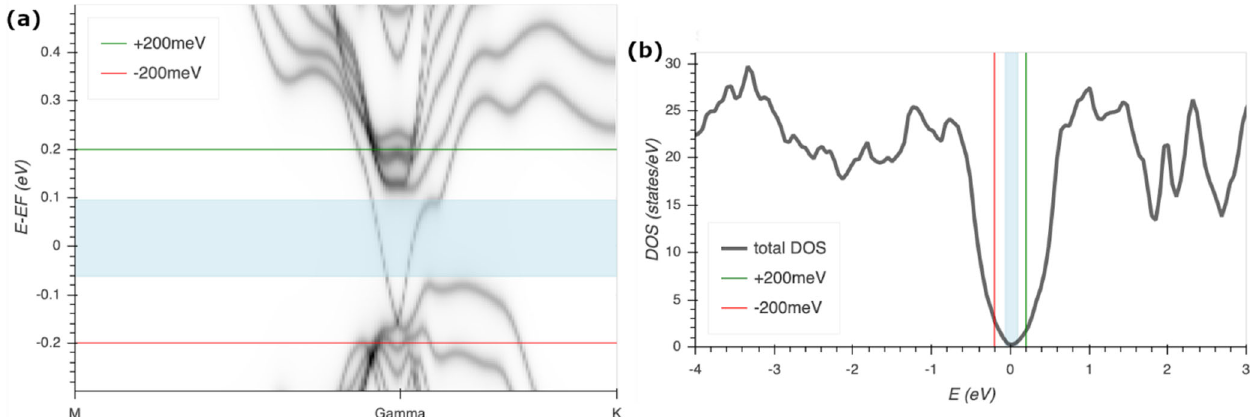
Fig. 6 Electronic structure of Sb 2 Te 3 . Band structure in terms of the Bloch spectral function ( a ) and density of states ( b ) of the 6 quintuple- layer thick Sb 2 Te 3 host crystal. Indicated are the bulk band-gap region (light blue region) as well as the in the considered Fermi level shifts (red and green lines) that are used to simulate the effect of p - and n -doping in the topological insulator host